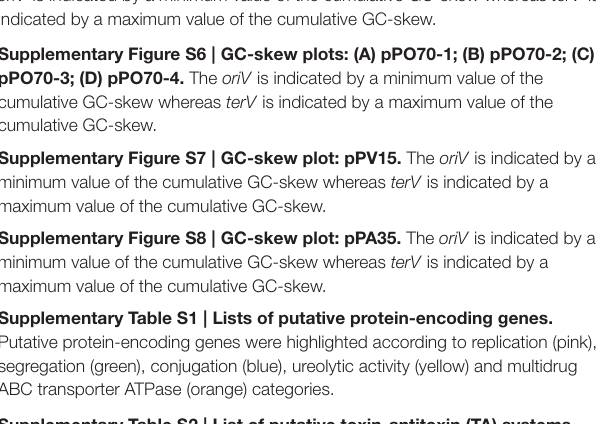
Supplementary Table S5 | List of putative resistance genes. Genes were highlighted according to the different resistance functions: Multidrug ABC transporter ATPase (blue), tetracycline (green), beta-lactamase (pink), aminoglycoside (orange), fluoroquinolone (gray), macrolide (yellow), chloramphenicol (brown), lincosamide